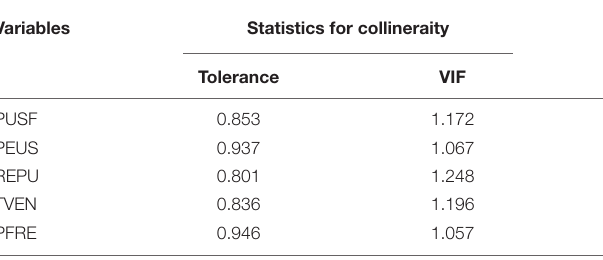
TABLE 5 | The results of the collinearity diagnostic test.